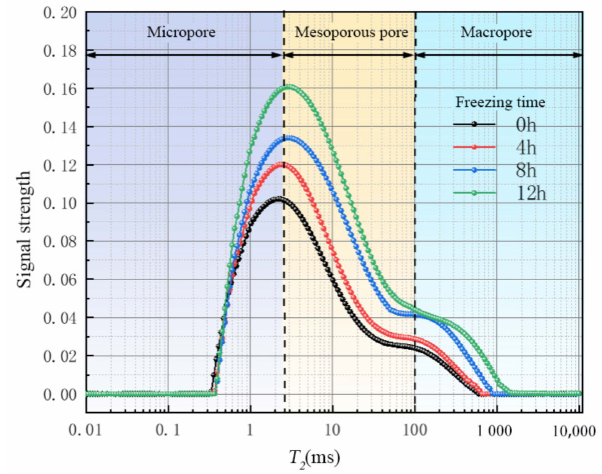
Figure 14. Pore size distribution of saturated sandstone during